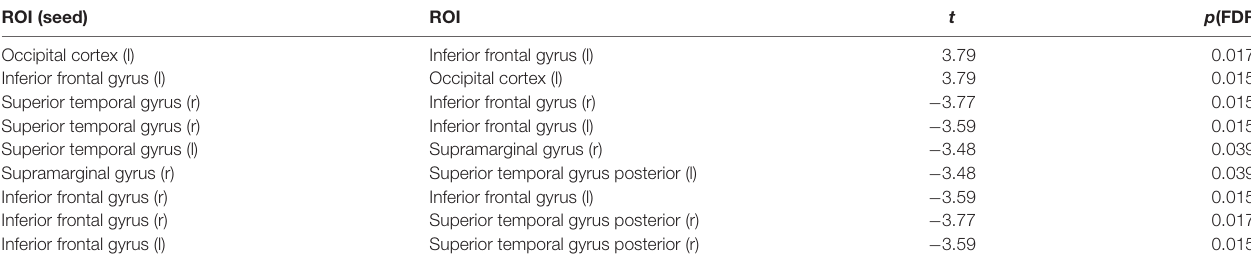
TABLE 3 | Association between resting-state functional connectivity and experienced bodily changes (“PLACEBO: Lourdes water”–“CONTROL: Tap water”). ROI